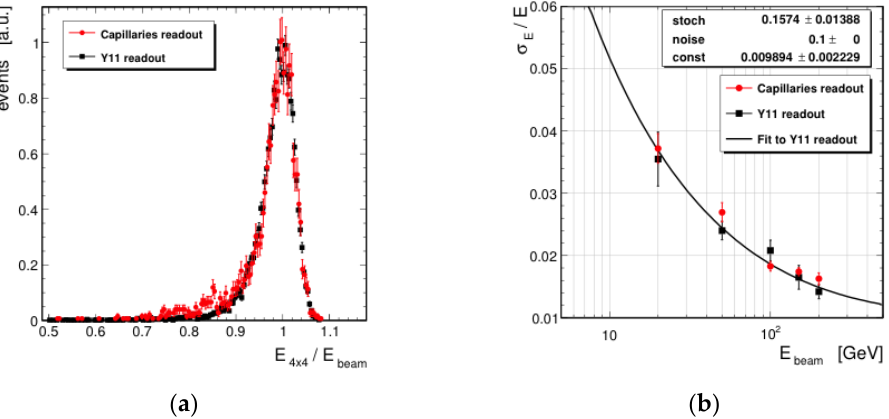
Figure 4. ( a ) Energy resolution for the 4 × 4 W/LYSO array using capillary WLS readout out (red) compared to Y11 double clad WLS fiber readout (black), as measured using an electron beam in the CERN H4 beam line. Electron beam energy is 100 GeV. ( b ) Energy resolution as a function of beam energy for the 4 × 4 W/LYSO array. These results indicate performance leading to a 1% constant term. √ The energy resolution achieved was: σ E /E = 15.7%/ E ⊕ 0.1/E ⊕ 1%. The 148 149 150